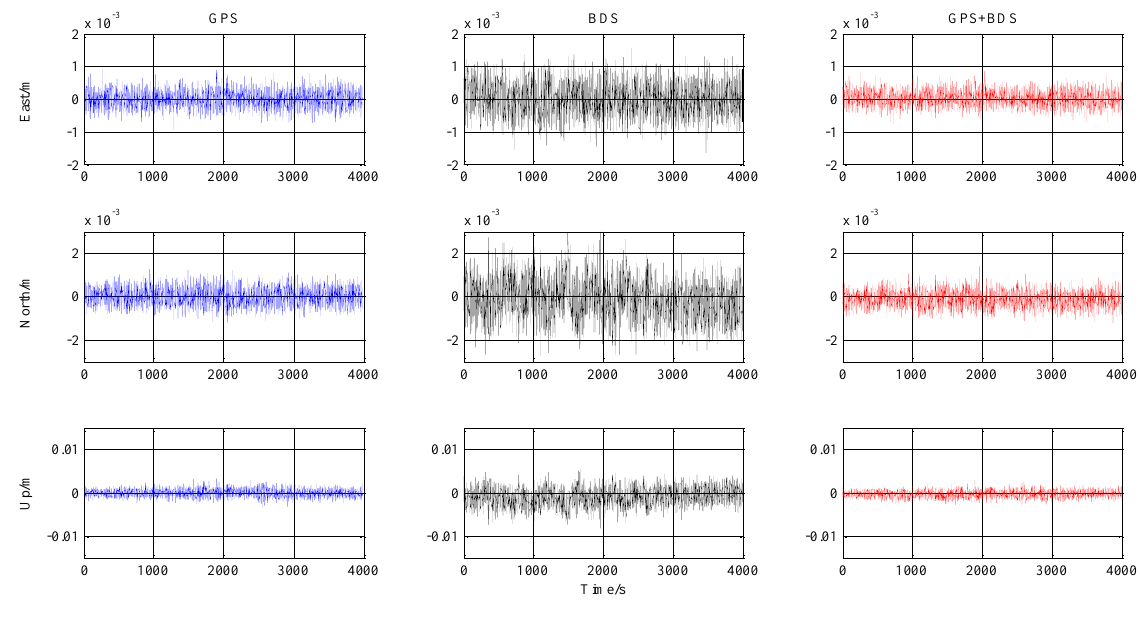
Figure 5. ENU baseline result of zero baseline experiment (all